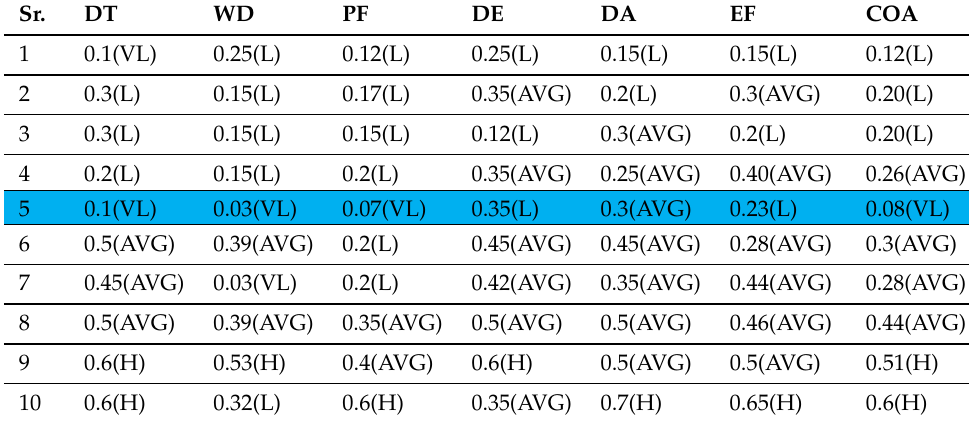
Figure 9. Sample Experiments Results from VLow to VHigh for COA. Table 3. Different Experiments Results Computed Using Rule